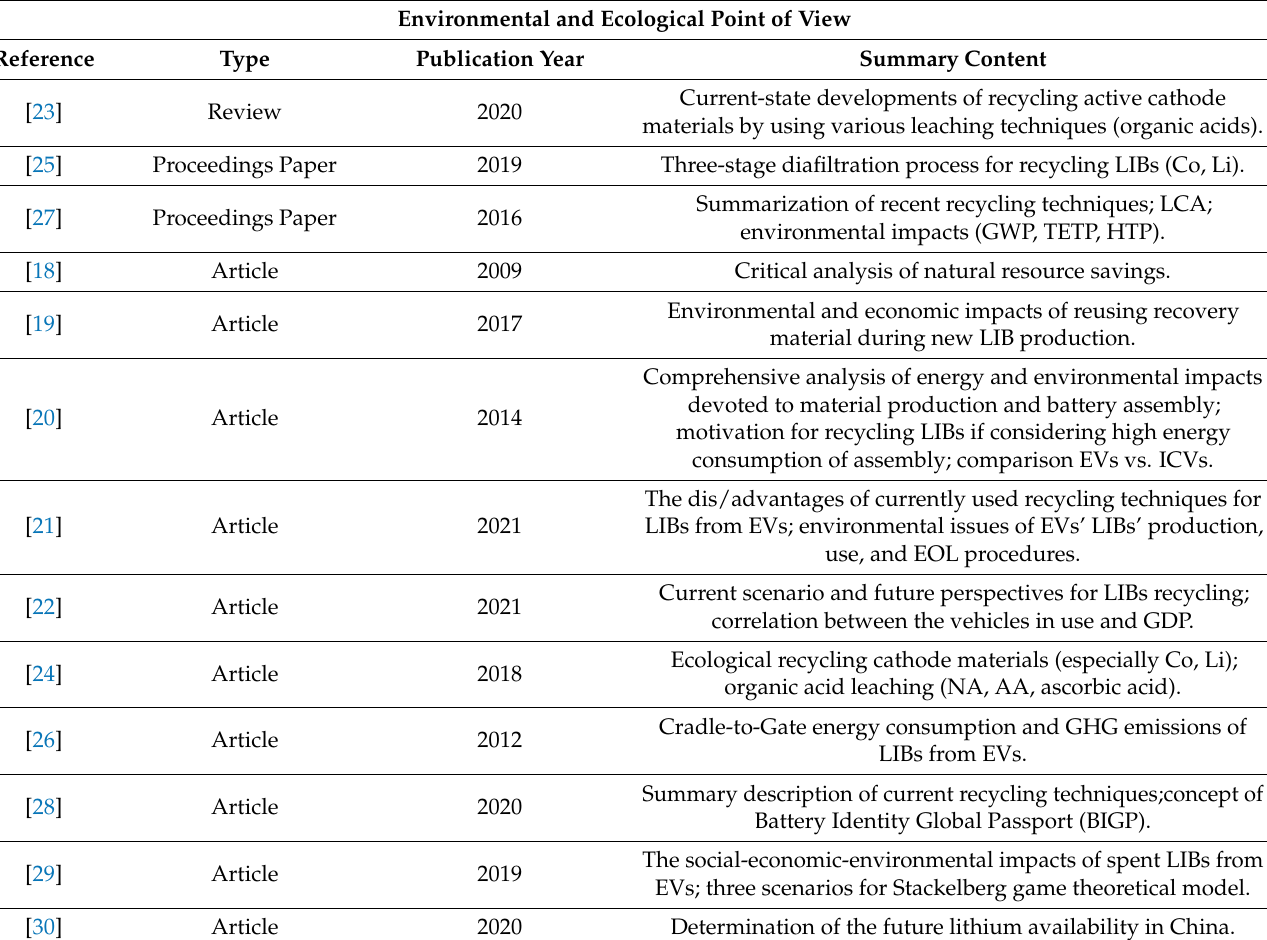
Table A2. Assessed literature in review for “Envi/Ecological Impact”